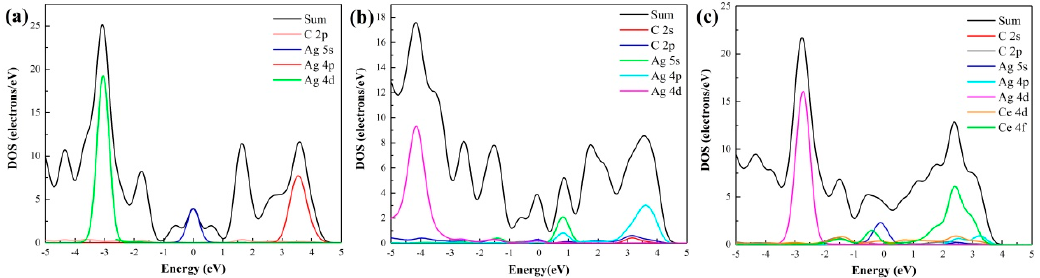
Figure 5. Partial DOS of absorbed Ag atom and its nearest C/Ce atom: ( a ) Intrinsic graphene; ( b ) VG; ( c ) Ce-doped graphene.